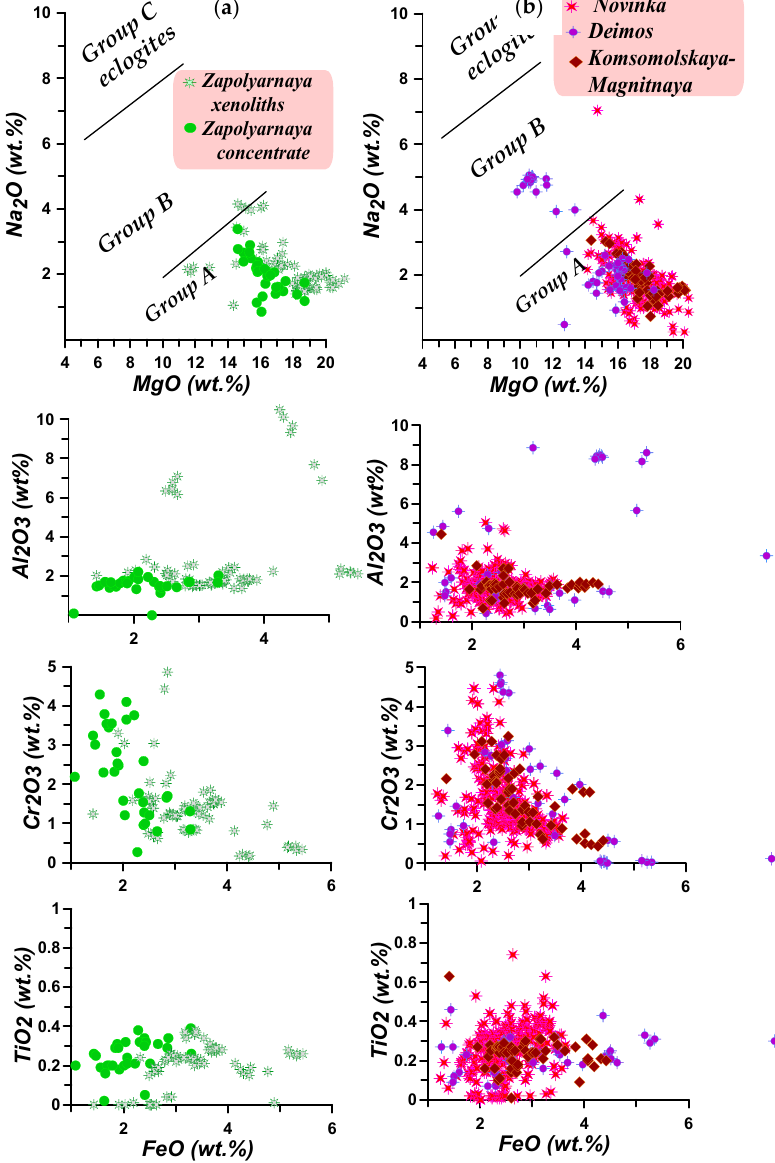
Figure 6. Compositions of Cr-diopsides, augites and omphacites from Upper Muna field. ( a ) Zapolyarnaya; ( b ) Novinka; Deimos, Komsomolskaya-Magnitnaya. Data for Novinka, Deimos, and Komsomolskaya-Magnitnaya are partly published [12]. Concentrate means heavy mineral separates.